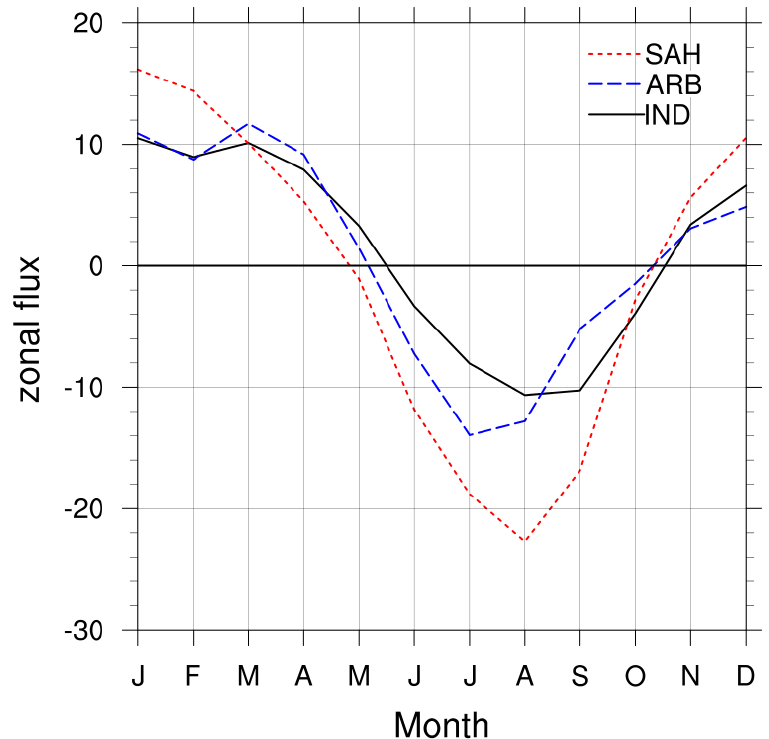
Figure 7. Monthly mean of zonal flux (in kg·(m·s) –1 ) between 500 and 300 hPa in India (70–90° E and 15–23° N, in red), Arabia (45–60° E and 15–20° N, in green), and Sahel (10° W–20° E and 10–20° N, in red) from January to December over the period 1998–2008.